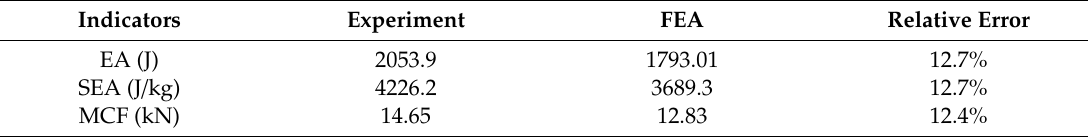
Figure 6. ( a ) Photograph of the experiment set-up, ( b ) deformed shapes of the specimen, and ( c ) comparison of force-displacement.